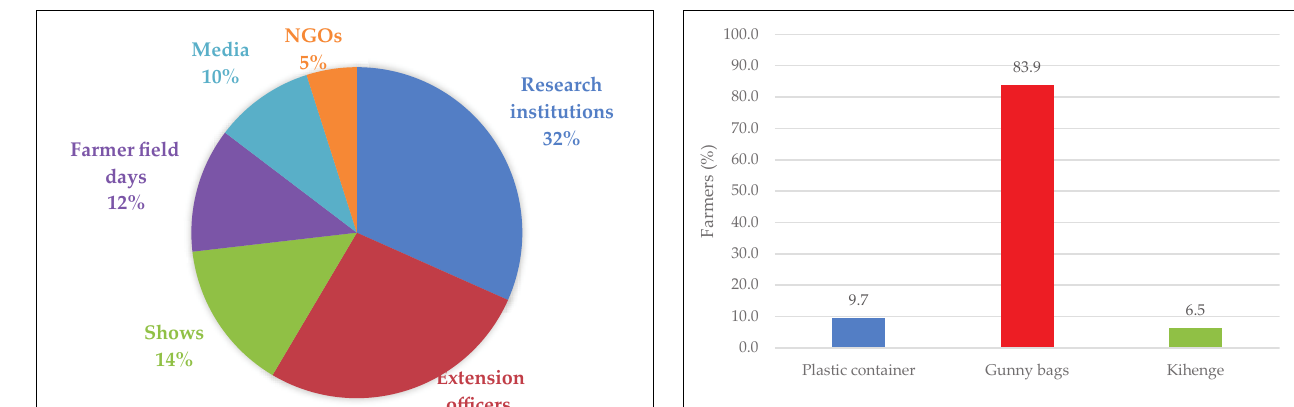
FIGURE 7 | Seed storage materials.